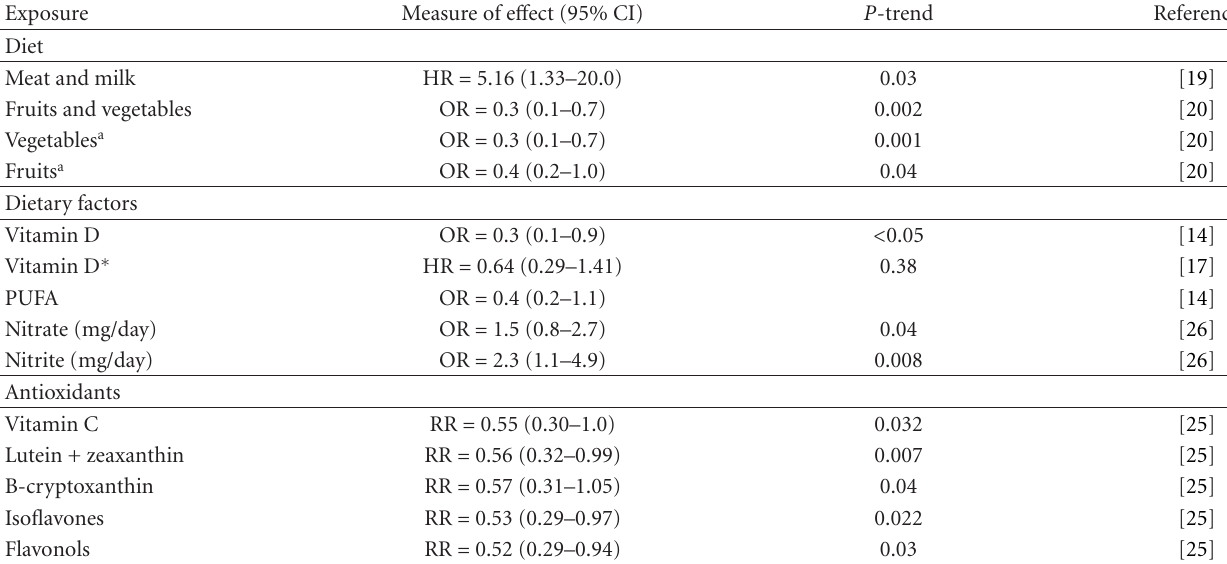
Table 1: Dietary risk factors associated with the development of follicular